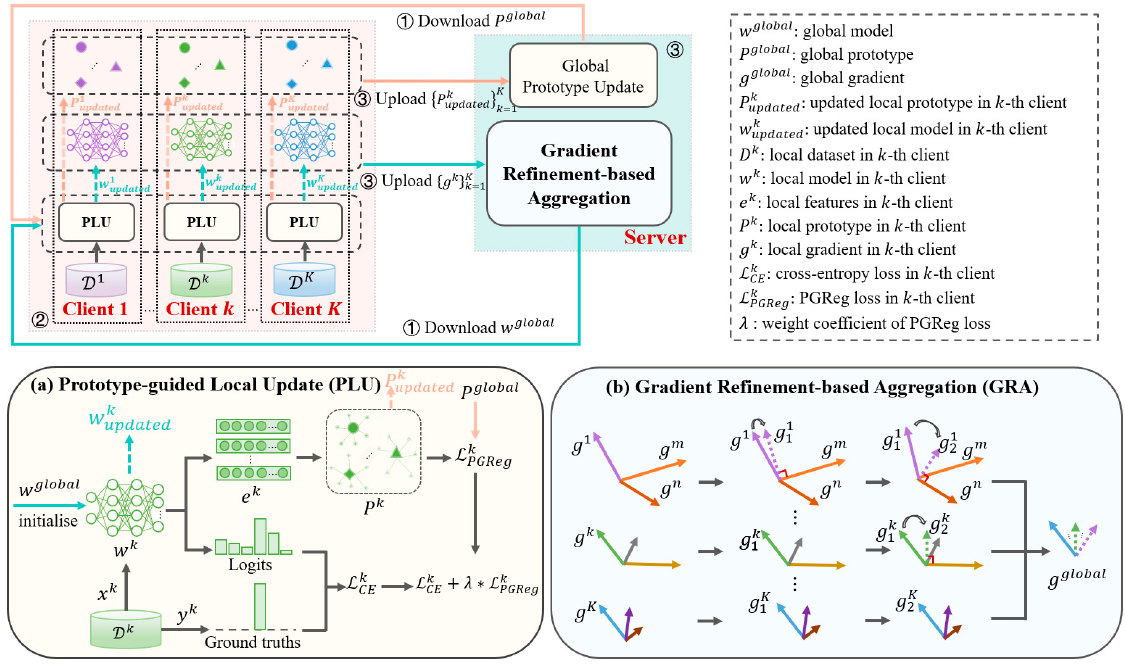
Figure 1. Overall architecture of our proposed FedAAR framework. The training of FedAAR consists of T communication rounds between a global server and K clients, where the workflow of each communication round includes three steps as follows. ① Each client k first downloads the same global model w global and global prototype 𝑃 (cid:3034)(cid:3039)(cid:3042)(cid:3029)(cid:3028)(cid:3039) from a global server simultaneously. ② Based on the local dataset D k in each client k , the local model w k is initialised and then trained in a prototype- guided local update (PLU) module (Figure 1 a ). After local training, the updated local model (cid:3038) 𝑤 (cid:3048)(cid:3043)(cid:3031)(cid:3028)(cid:3047)(cid:3032)(cid:3031)